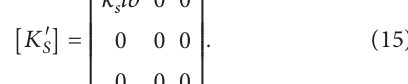
of each element are shown in Tables 1 and